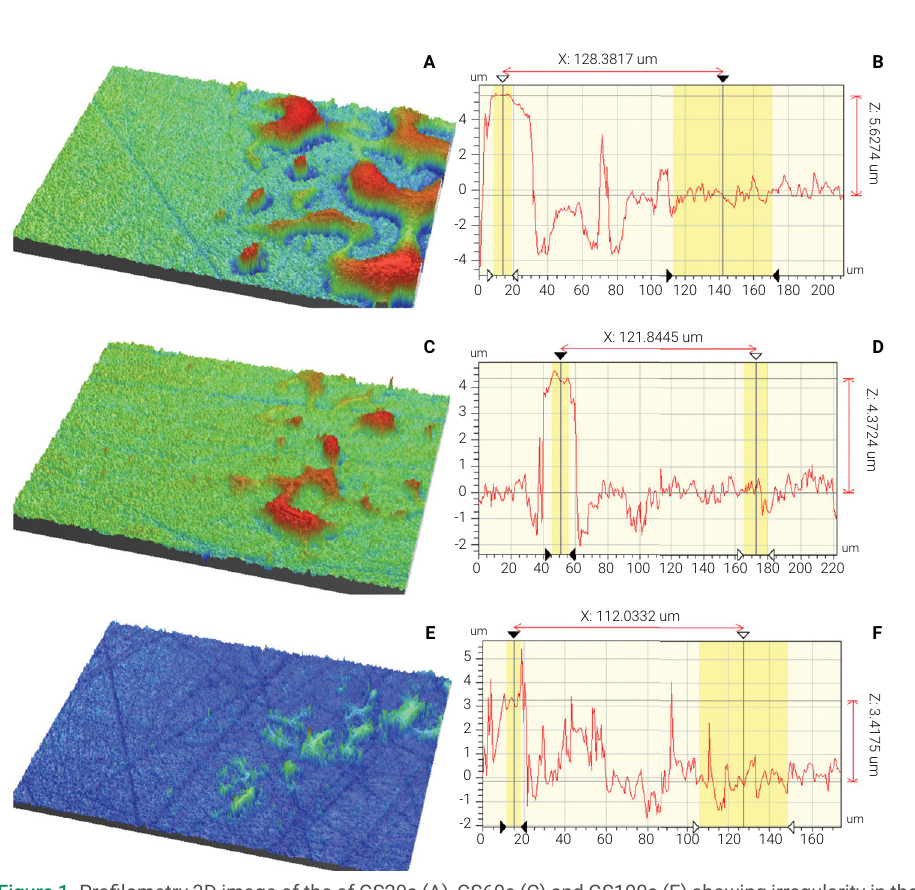
Figure 1. Profilometry 3D image of the of GS20s (A), GS60s (C) and GS100s (E) showing irregularity in the arrangement of applied glaze spray and their remaining glaze thickness measurements, indicating the average layer thickness 5 ± 1μm (B), 4 ± 1μm (D) and 3 ± 1μm